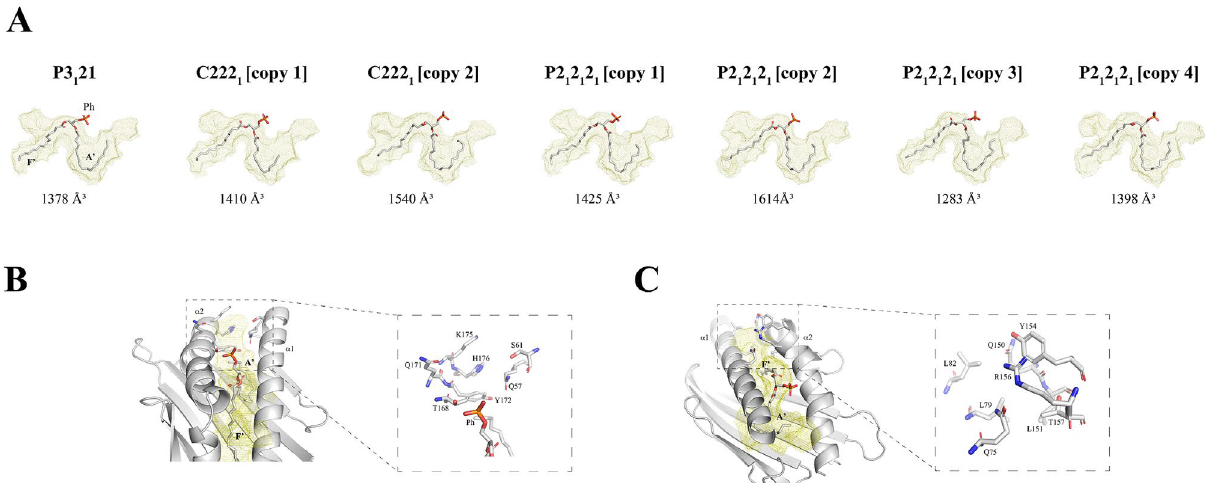
Figure 6. Morphology of the EPCR lipid-binding cavity. ( A ) The space that depicts the lipid pocket in each EPCR structure is displayed as a paleyellow mesh, with the phospholipid (Ph) molecule inside, as it is present in the crystal structure. The A’ and F’ pockets are indicated in the P3 1 21 structure. Pockets were determined with DoGSiteScorer 55 ( B ) Visualization of the additional pocket detected in EPCR near A’. Shown is the structure corresponding to space group P2 1 2 1 2 1 , copy 4, in grey cartoon representation. The residues that surround each pocket are highlighted in stick format, and additionally, in a zoomed-in side image. ( C ) As in ( B ), the